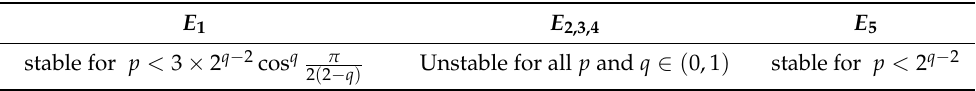
Table 2. Stability of equilibria E i , i = 1,2, . . . ,5.